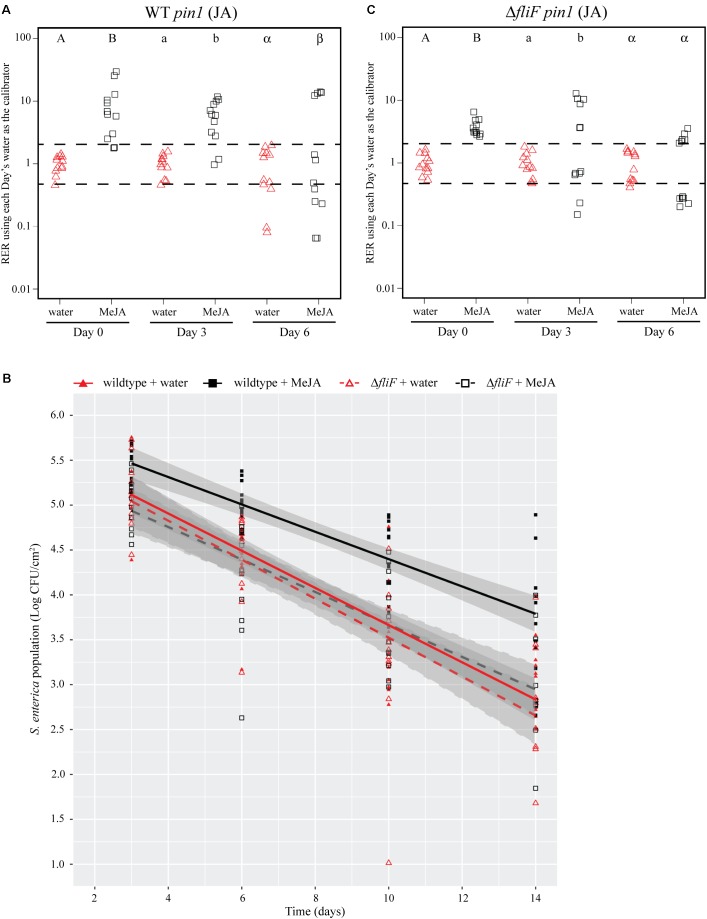
Induction of the JA response with a chemical analog increases S. Typhimurium survival over time. (A,C) Plant pin1 gene expression was quantified at days 0, 3, and 6 post-inoculation with wildtype S. Typhimurium (A) or the fliF::Kan mutant (C) for plants sprayed with water (red triangles) or methyl jasmonate (MeJA; black squares) and displayed as relative expression ratios (RER) using transcription on plants treated with water as the calibrator. The dashed line indicates a twofold change in transcription, and each symbol represents data collected from one tomato plant. Transcript levels were quantified from three biological replicates with samples taken from four plants per treatment per time point. Letters denote significant differences between treatments within a single time point (P < 0.05). (B) Bacterial populations on leaves were monitored over time following either treatment with water (red triangles) or MeJA (black squares) 24 h prior to bacterial dip inoculation. All data points from three independent experiments were combined and presented as S. Typhimurium populations (log CFU/cm2) over a 14-day period. Lines (red, solid: wildtype S. enterica after water treatment; black, solid: wildtype S. Typhimurium after MeJA treatment; red, dashed: fliF::Kan after water treatment; black, dashed: fliF::Kan after MeJA treatment) correspond to a linear regression model, and shaded areas correspond to the respective 95% confidence interval.